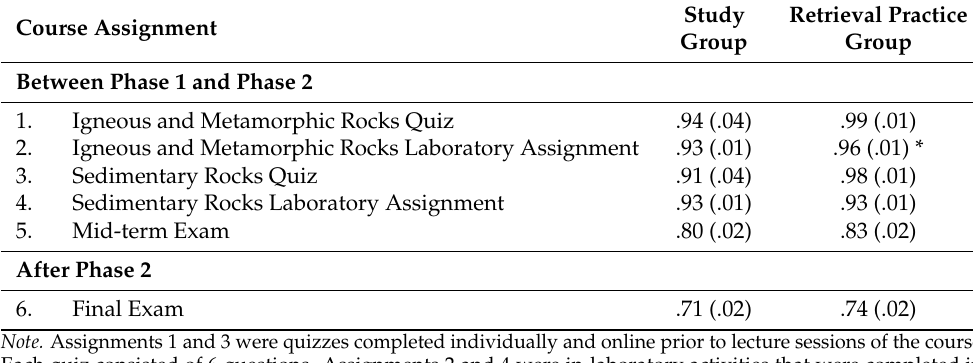
Table 2. Students’ Performance on Coursework Related to the